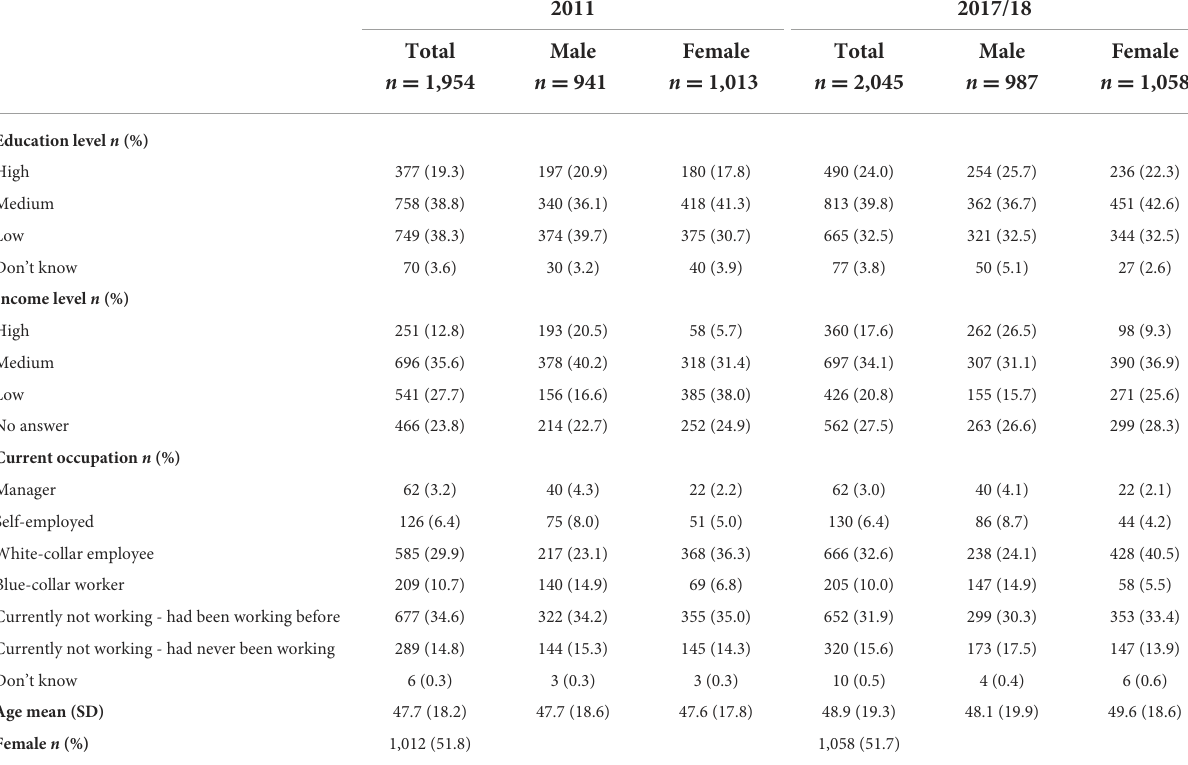
TABLE 1 Sample characteristics for 2011 and 2017/18, overall and by